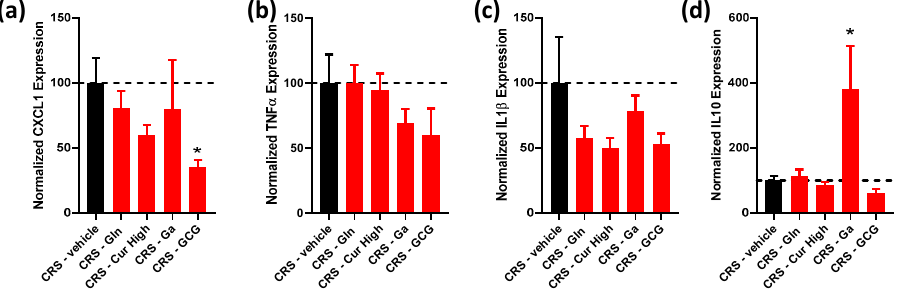
Figure 5. Effect of each selected compound administered individually and the GCG mix on colonic inflammation-related gene expression. ( a ) Normalized CXCL1, ( b ) TNF α , ( c ) IL1 β and ( d ) IL10 gene expression in CRS (black bars) vs. CRS-Glutamine (Gln), CRS-Curcuméga ® (Cur) at high and low doses, CRS-Gabolysat ® (Ga) and CRS-GCG groups (red bars). n = 4–18 per group. Data are presented as means ± SEM. Data were compared by one-way ANOVA with Dunnett’s post hoc tests ( a – c ) or Kruskal–Wallis with Dunn’s post hoc tests ( d ). *, p < 0.05 vs. CRS-vehicle. Dashed line represents the level observed in untreated CRS mice.